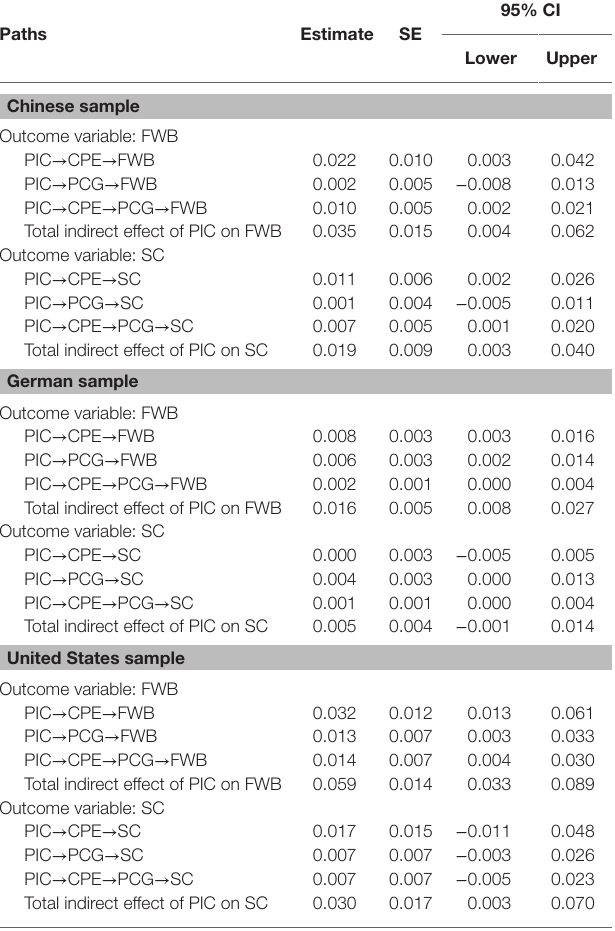
TABLE 6 | Indirect effects of PCI on FWB and SC for China, Germany, and the United States.